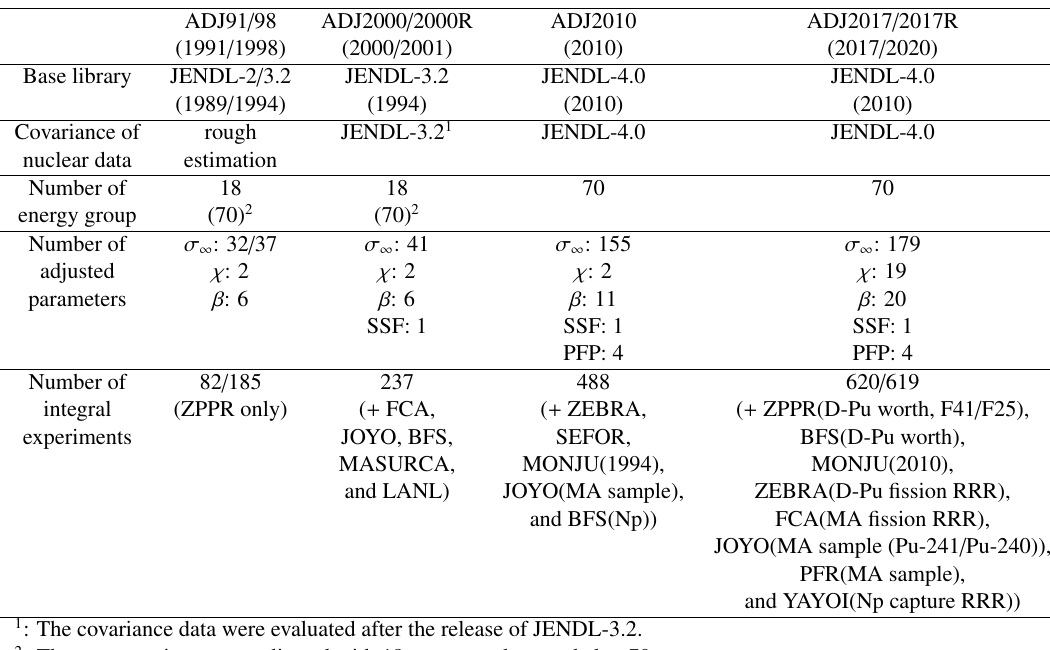
Table 1. Features of unified (adjusted) cross-section sets developed in